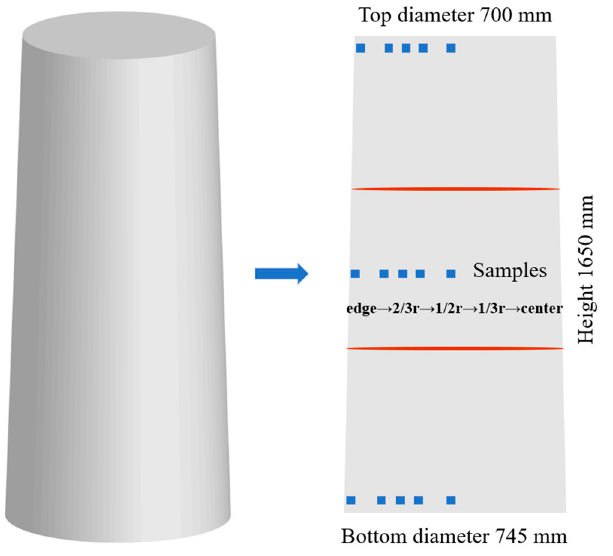
Figure 1. Schematic diagram of sampling position.